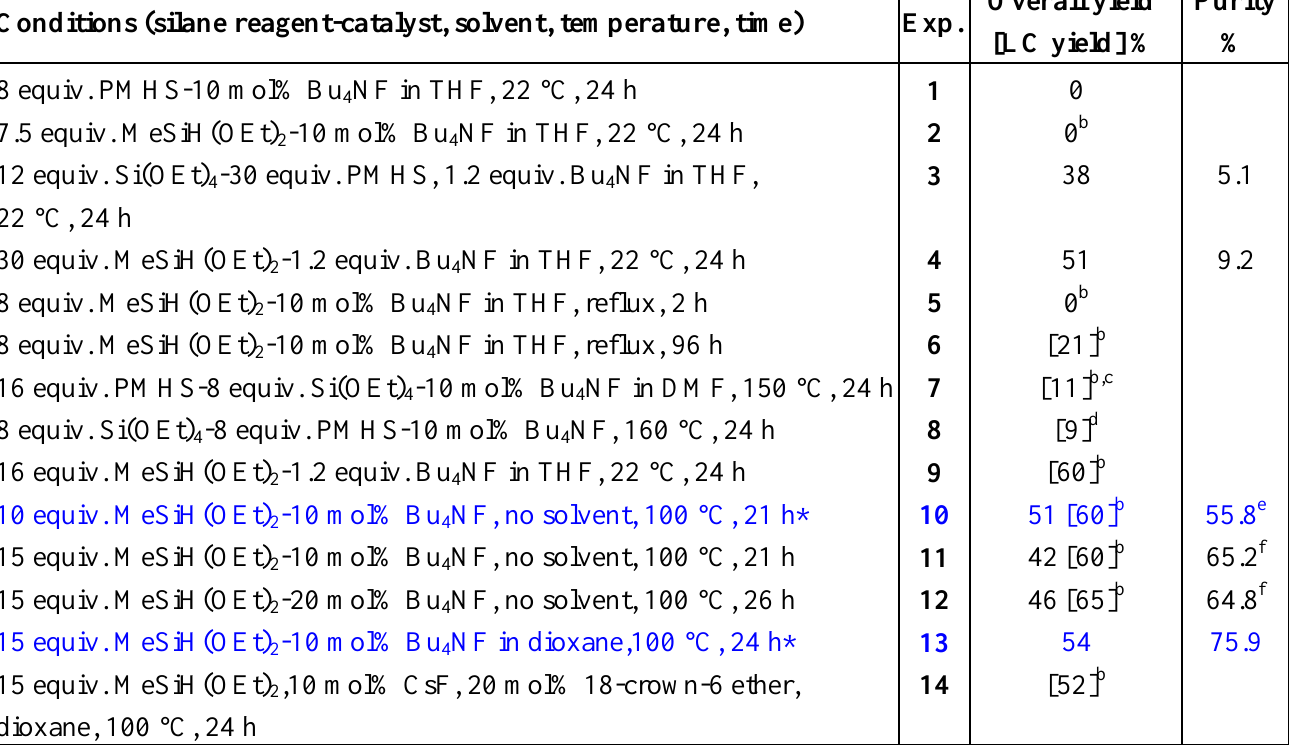
Conditions (silane reagent-catalyst, solvent, temperature, time)